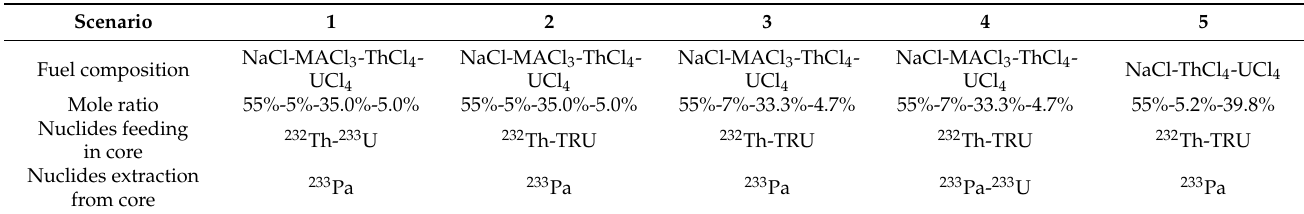
Table 3. MA incineration scenarios.